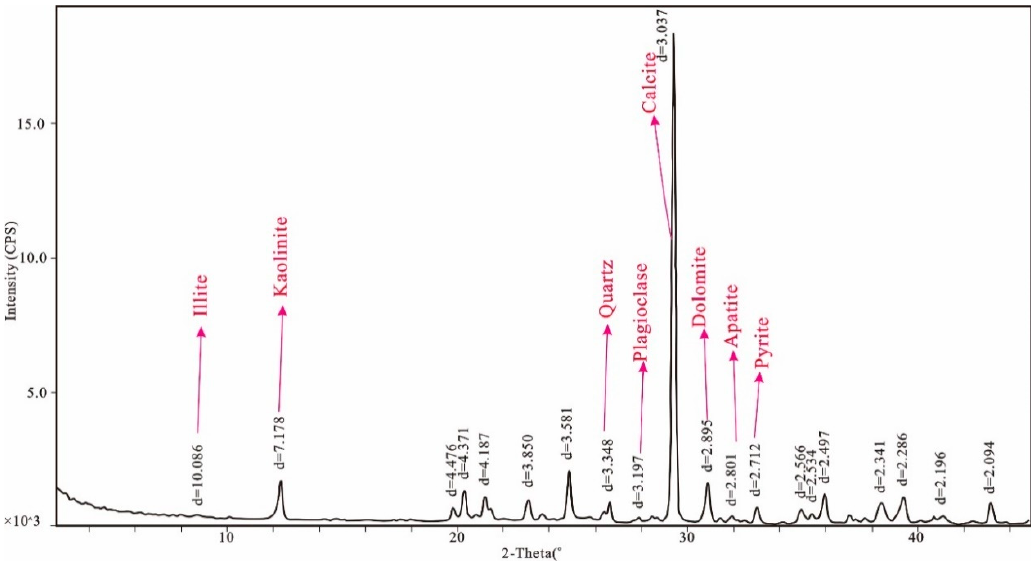
Figure 8. Power X-ray diffraction pattern of the low temperature ash of sample DP5 -2 -5 from Dongpo Mine.